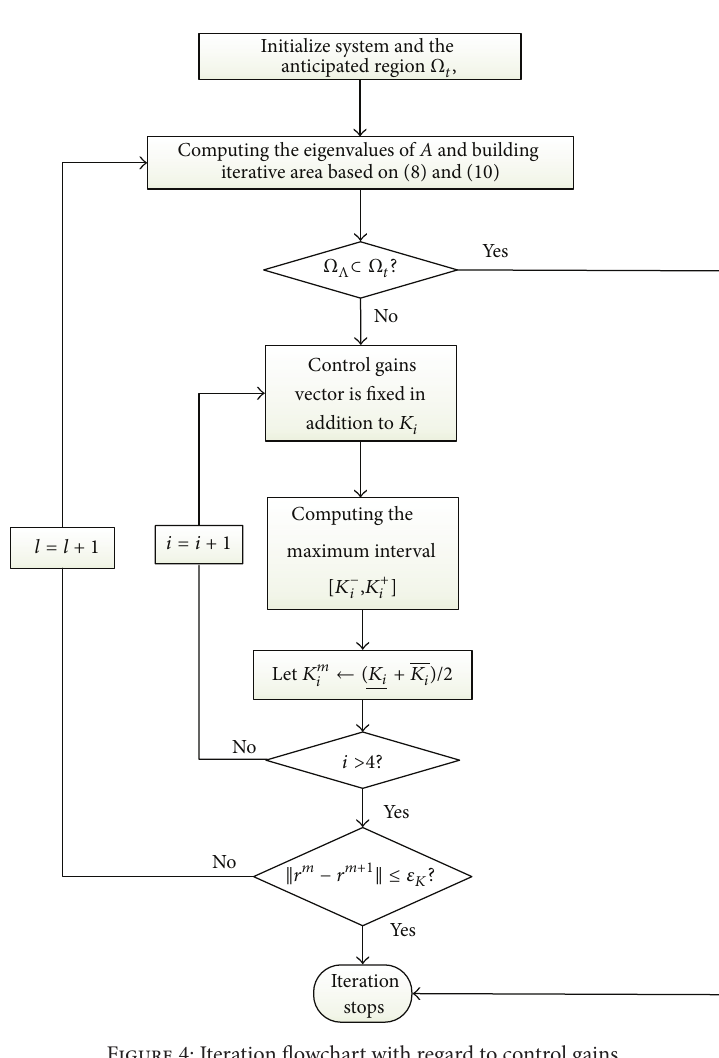
Figure 4: Iteration flowchart with regard to control gains.